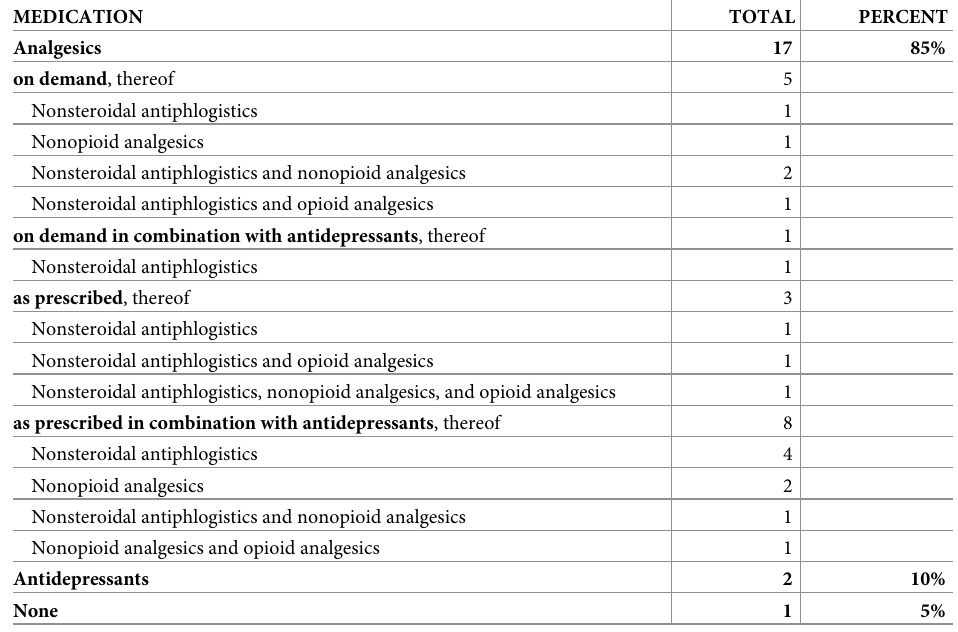
Table 2. Medication of chronic pain patients. MEDICATION TOTAL PERCENT Analgesics 17 85% on demand , thereof Nonsteroidal antiphlogistics Nonopioid analgesics Nonsteroidal antiphlogistics and nonopioid analgesics Nonsteroidal antiphlogistics and opioid analgesics on demand in combination with antidepressants , thereof Nonsteroidal antiphlogistics as prescribed , thereof Nonsteroidal antiphlogistics Nonsteroidal antiphlogistics and opioid analgesics Nonsteroidal antiphlogistics, nonopioid analgesics, and opioid analgesics as prescribed in combination with antidepressants , thereof Nonsteroidal antiphlogistics Nonopioid analgesics 2 Nonsteroidal antiphlogistics and nonopioid analgesics 1 Nonopioid analgesics and opioid analgesics 1 Antidepressants 2 10% None 1 5% Note. Analgesics consumed as prescribed were taken at least once a